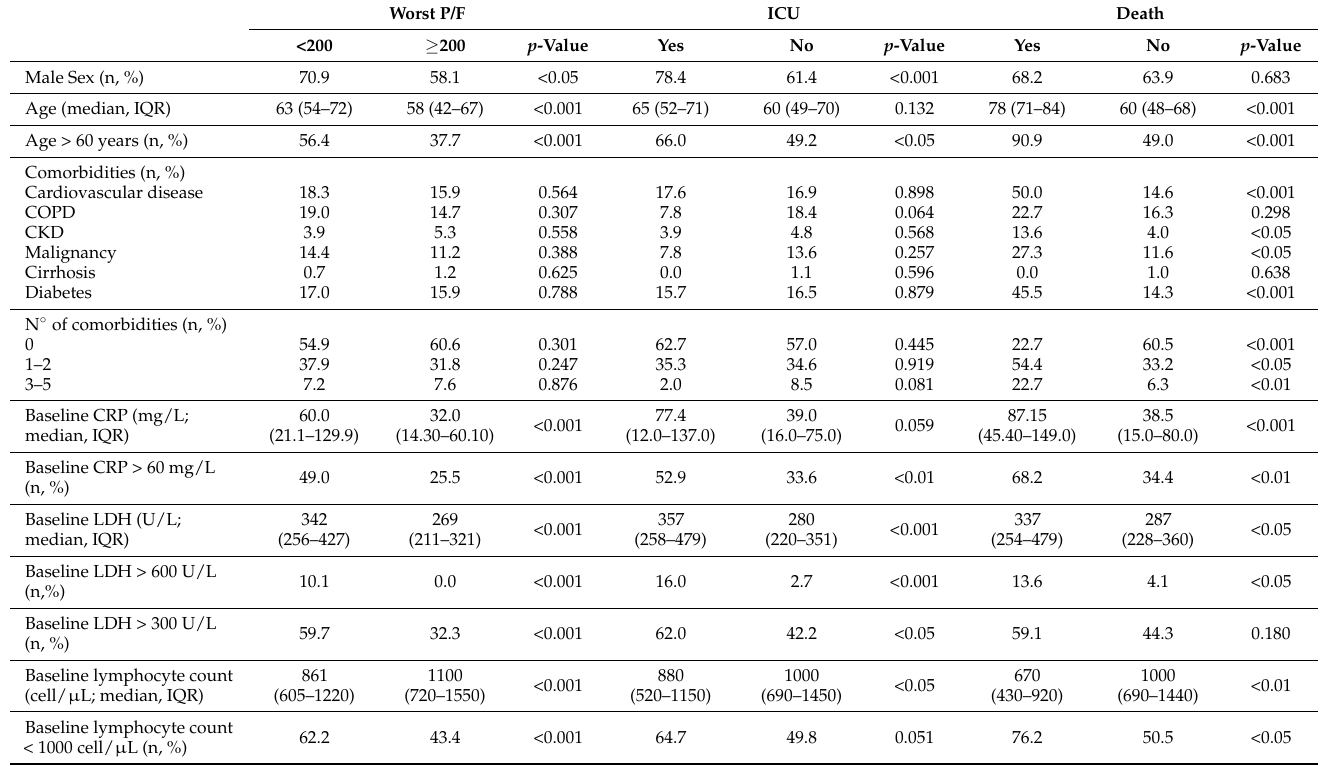
Table 2. Differences in the demographic and laboratory parameters among included patients, strati- fied according to the presence or the absence of three unfavourable outcomes (Worst P/F ratio < 200 during hospitalization, ICU admission,